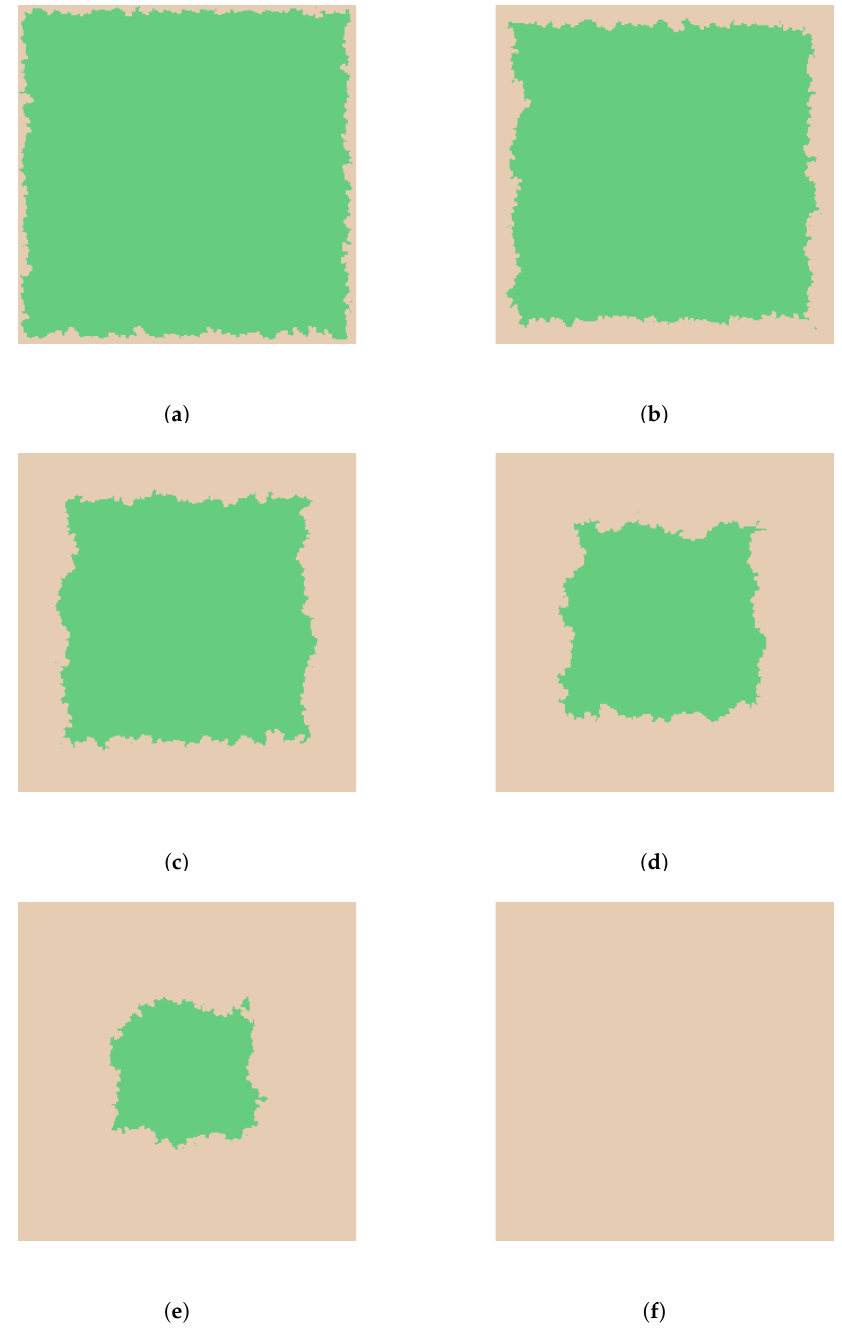
Figure 3. Eden model simulation of epithelialization for a square skin wound. is wound space and is epithelialization. Different stages of the onset and progression of epithelialization showing wound contraction and leading closure are given in ( a – f ), representing 10%, 25%, 50%, 70%, 85%, and 100% percentage re-epithelialization,